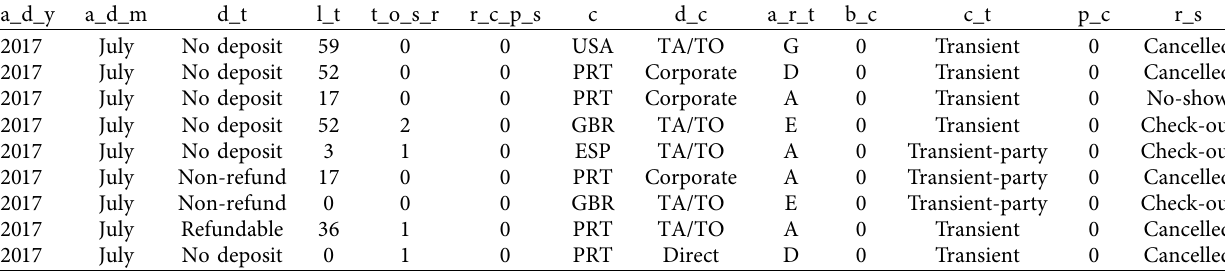
Table 2: Booking demand data.